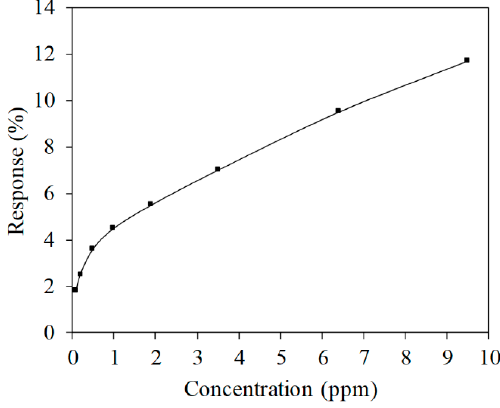
Figure 12. Response of the AGS.